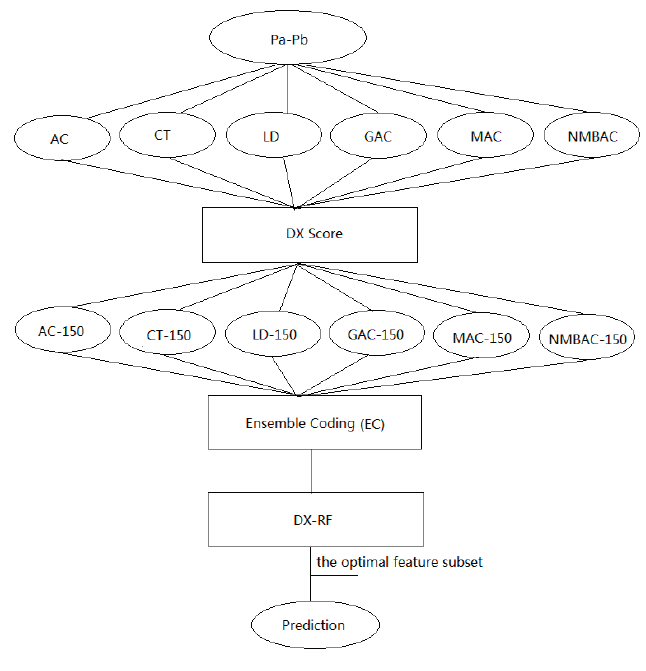
Figure 21. Framework of EC scheme for protein sequence pairs. AC-150 denotes the top-ranked 150 features; the other features are the same as AC-150 and DX-RF. We adopt the RF algorithm to evaluate the importance of each feature with the DX score by adding features